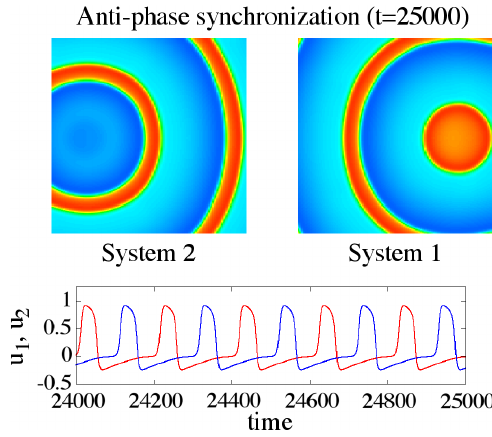
are the same as in Fig. 3 except for ð 0 Þ ¼ 1 . 16 . The bottom figure shows the evolution of the activator variables u 1 and u 2 at the corresponding locations, i.e., ð x 1 ; y 1 Þ ¼ ð 3 L= 4 ; L= 4 Þ of system 1 and ð x 2 ; y 2 Þ ¼ ð L= 4 ; L= 4 Þ of system 2.